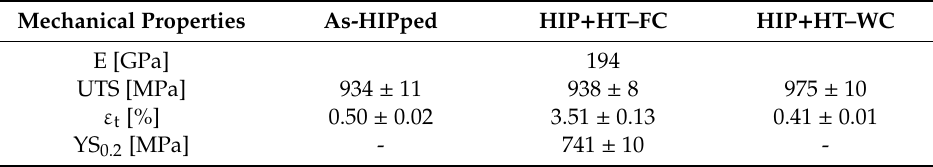
Table 6. Tensile properties of as-HIPped and heat treated